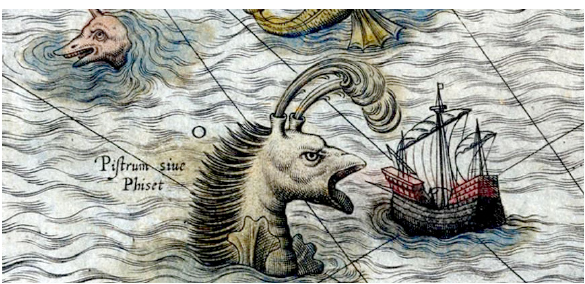
Figure 3: The fearsome Pistrum or Phiset: detail from Olaus Magnus, 1572, Carta